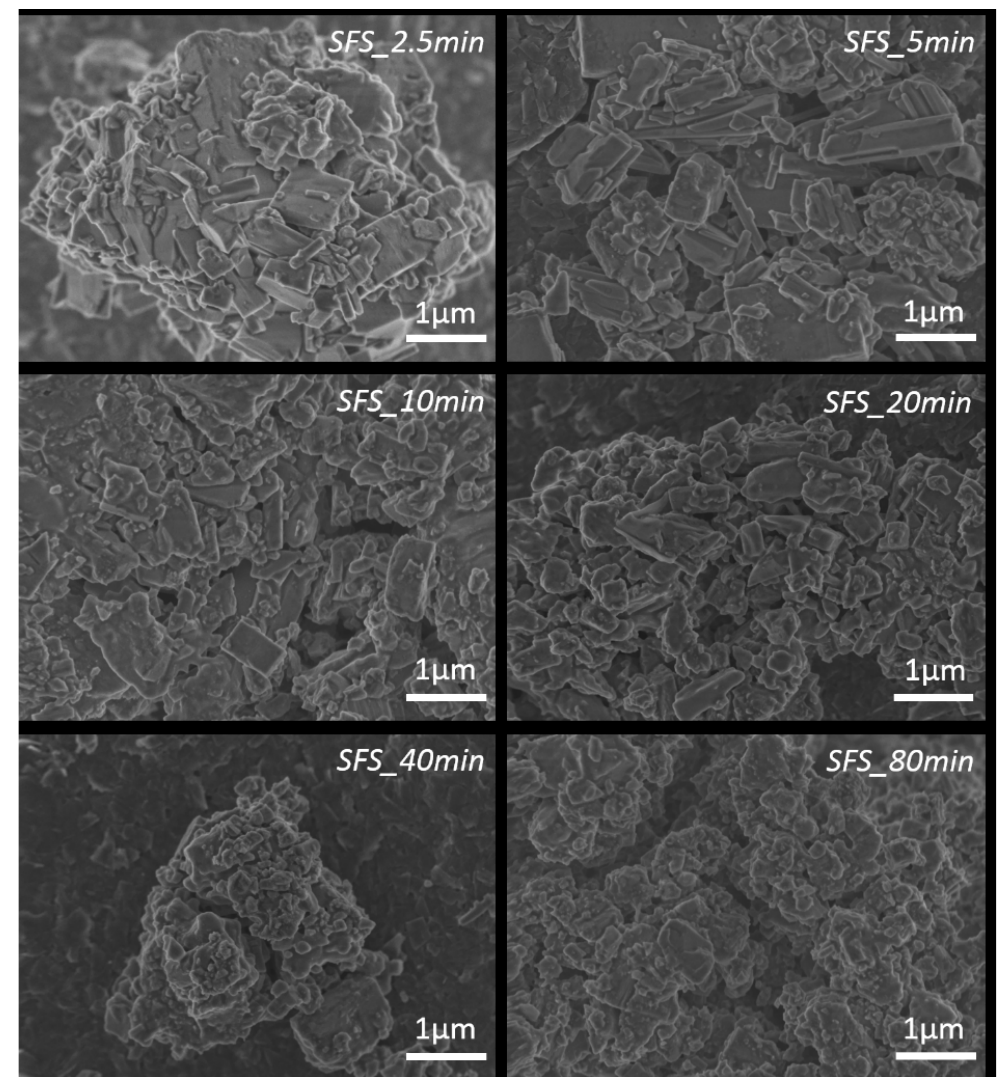
Figure 2. FEG-SEM micrographs of simple superphosphate (SSP) fertilizer milled at different times.